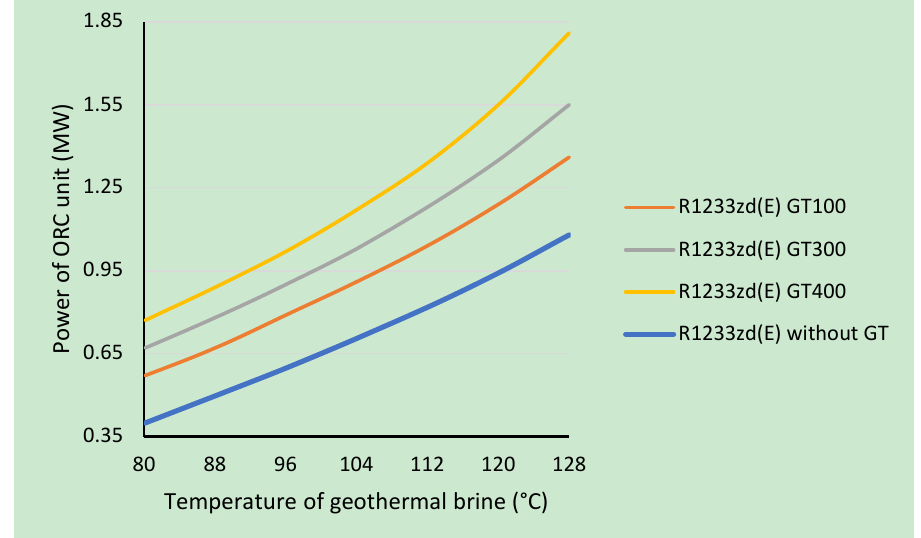
Figure 10. The power of ORC section in the modified system (assisted by gas turbine) as a function of the geothermal brine temperature with R1233zd(E) as a working fluid for di ff erent gas turbine